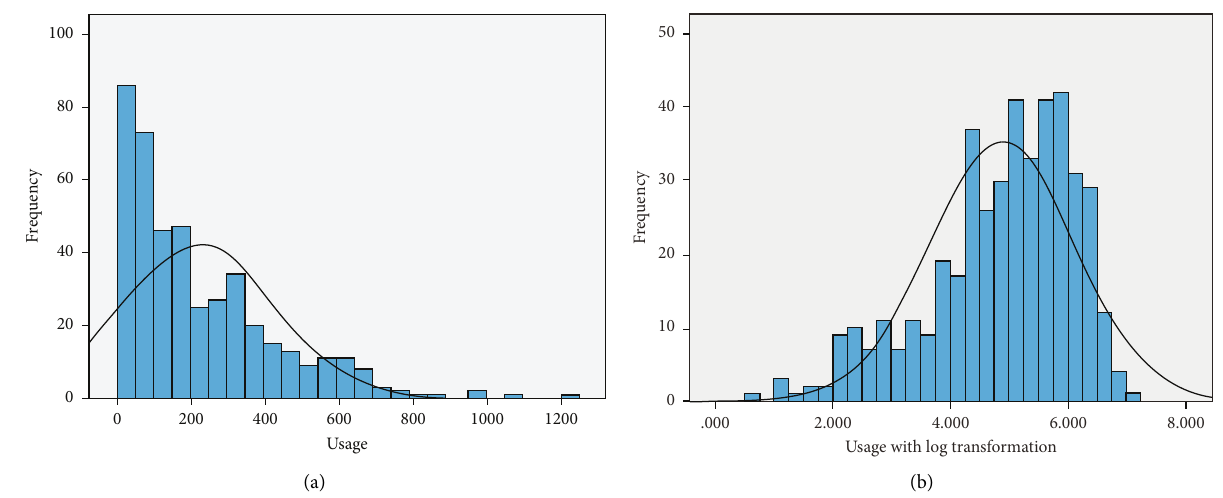
Figure 7: Histogram of the bike-sharing usage with and without log transformation: (a) histogram of the bike-sharing usage and (b) histogram of the bike-sharing usage with log